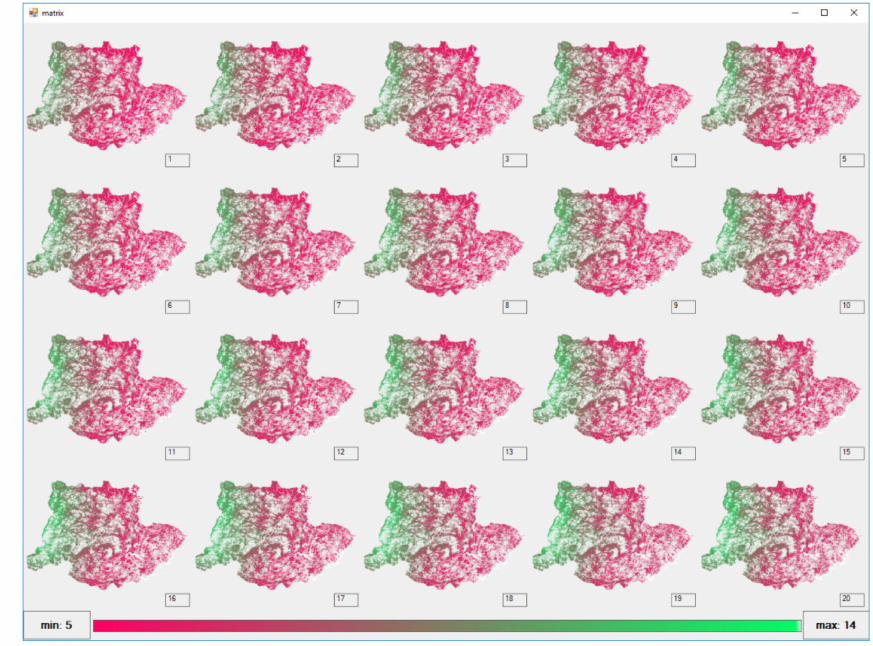
Figure A4. Price distribution for Scenario 1 (Biomass I (B1), thinning) over a period of 20 years (t 1 to t 20 ) in the Nordeste region, Portugal. The minimum price was 5 € / m 3 (light red) and the maximum 14 € / m 3 (light